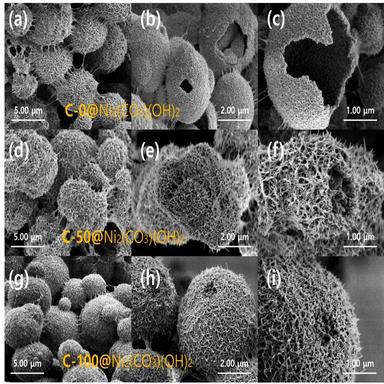
Low- and high-magnification SEM images of (a–c) Ni2(CO3)(OH)2 nanowires; (d–f) C-50@Ni2(CO3)(OH)2 nanowires; (g–i) C-100@Ni2(CO3)(OH)2 nanowires grown on the Ni foam.